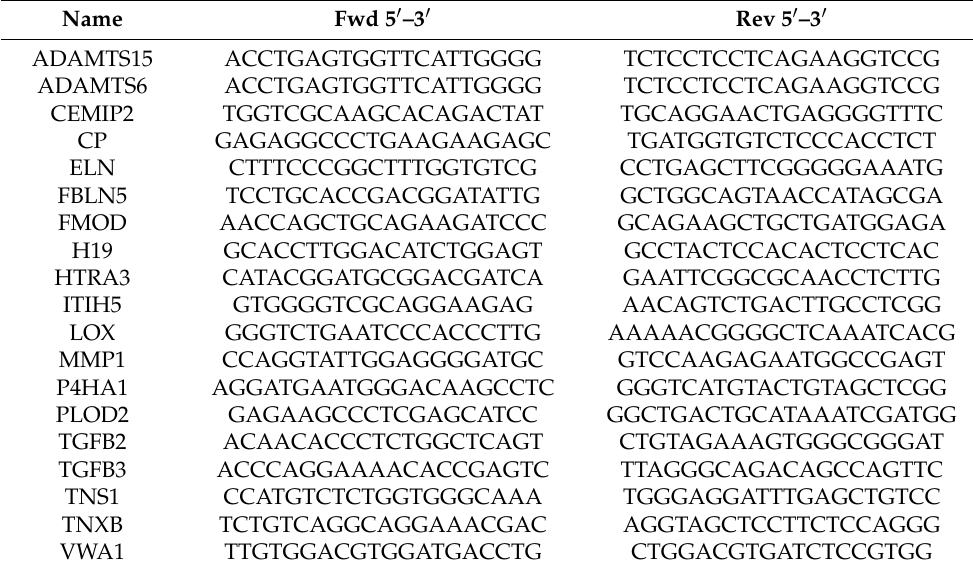
Table 1. Primers used for